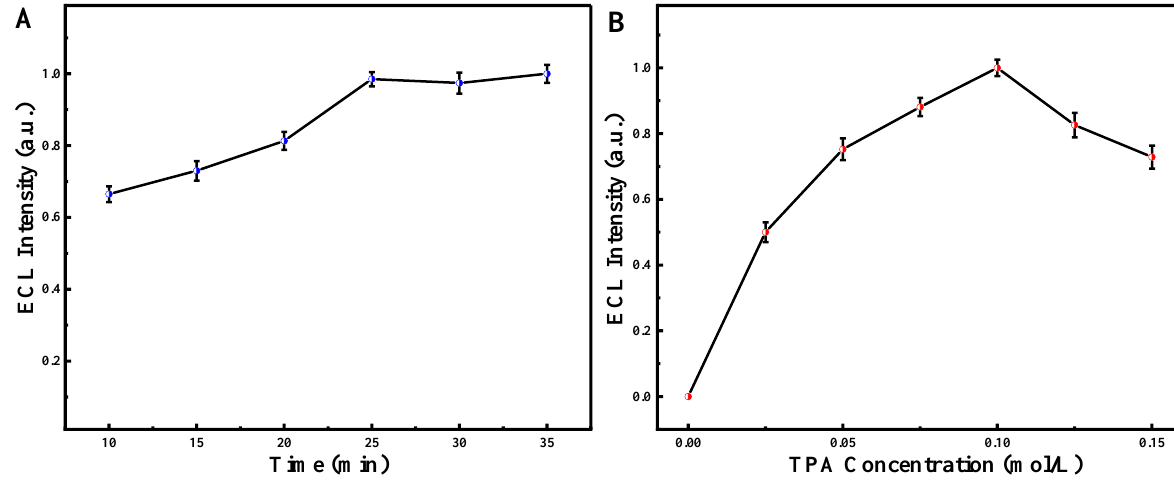
Figure 6. The effects of incubation time of CEA ( A ) and the concentration of TPA ( B ). In addition, different concentrations of CEA antigen were incubated under the con- dition of GCE/Ru-Au-WS 2 /Ab/BSA modified electrodes as substrates. The quantitative de- tection of CEA antigen was realized in 0.1 mol·L −1 TPA solution. As shown in Figure 7, the